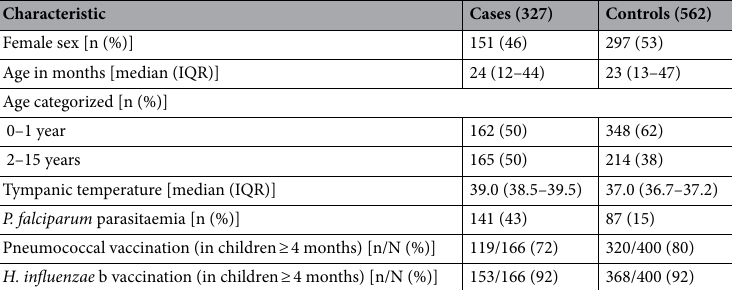
Table 1. Baseline characteristics of study participants by cases admitted with lower respiratory tract infections and controls. IQR, interquartile range; URTI, upper respiratory tract infections.